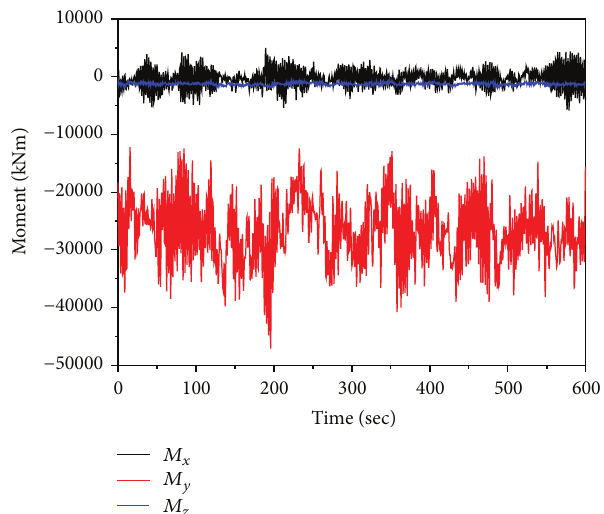
Figure 7: Wind moments at TP for DLC 6.2ja-2.